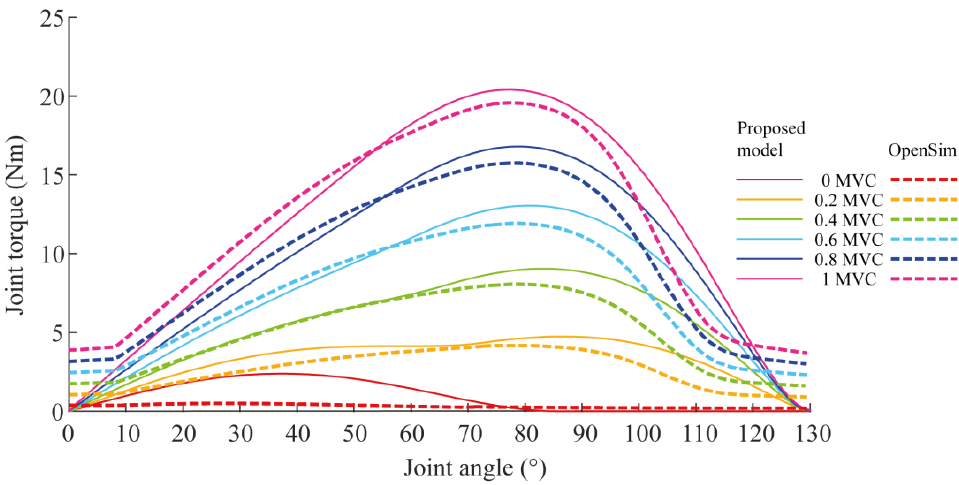
Figure 3. Comparison between the muscle torque – joint angle curves of the BRD muscle calculated with the model proposed in this study (continuous line) with respect to those calculated with the musculoskeletal modeling software OpenSim ® (dashed line) for different activation levels.